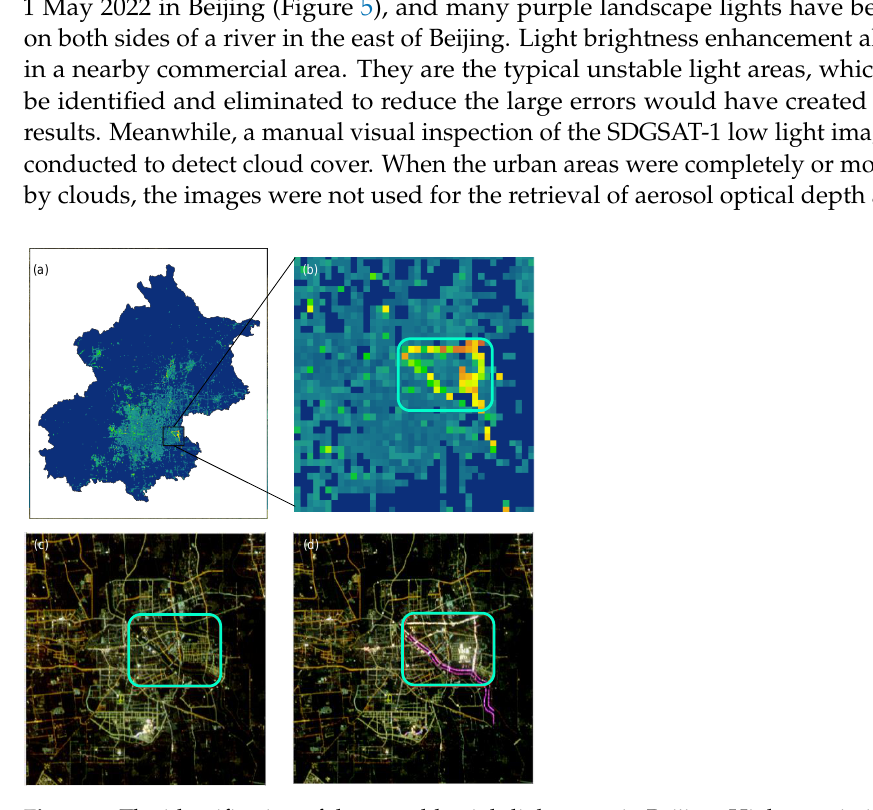
Figure 5. The identification of the unstable nightlight areas in Beijing. Higher variation coefficient area ( b ) in Beijing was identified according to the variation coefficient synthesized using radiance value for many days ( a ), and the nightlight images obtained on 15 April 2022 ( c ) and 1 May 2022 ( d ) by SDGSAT-1 could identify the abrupt-change regions.